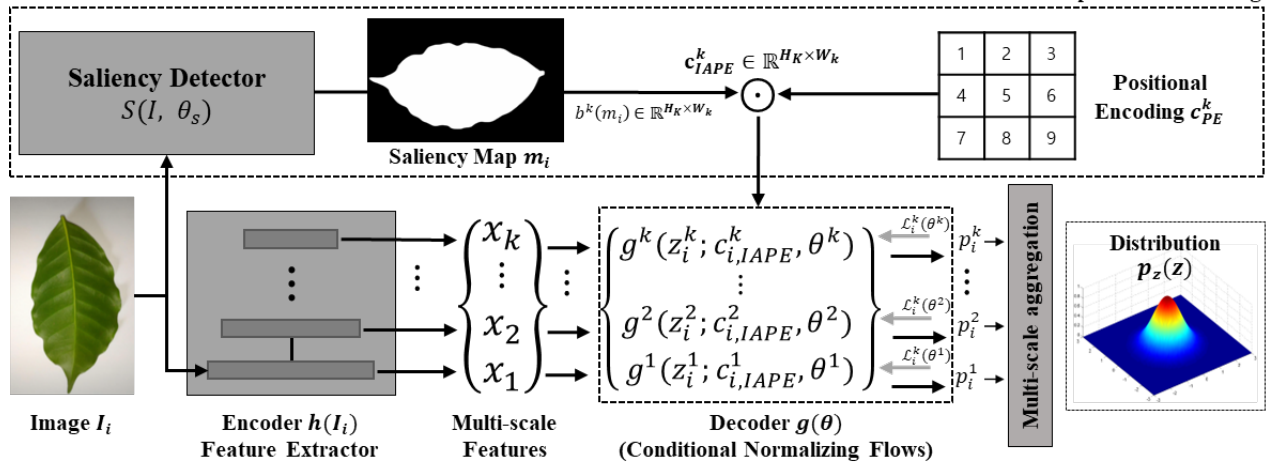
Figure 1. Architecture of proposed approach IA-PDD. In this pipeline, RGB images I i are inputs to saliency detector S ( I , θ s ) and feature extractor h ( I i ) . The saliency detector and feature extractor output a saliency map m i and multi-scale features, accordingly. Then, the saliency map, multi-scale features, and a positional encoding c k are fed into the set of decoders g ( θ ) , a.k.a. conditional normalizing PE flows, independently. The outputs of the flow network are aggregated and then used to estimate multi-scale likelihoods p z ( z ) . Finally, multi-scale likelihoods are used to calculate an anomaly